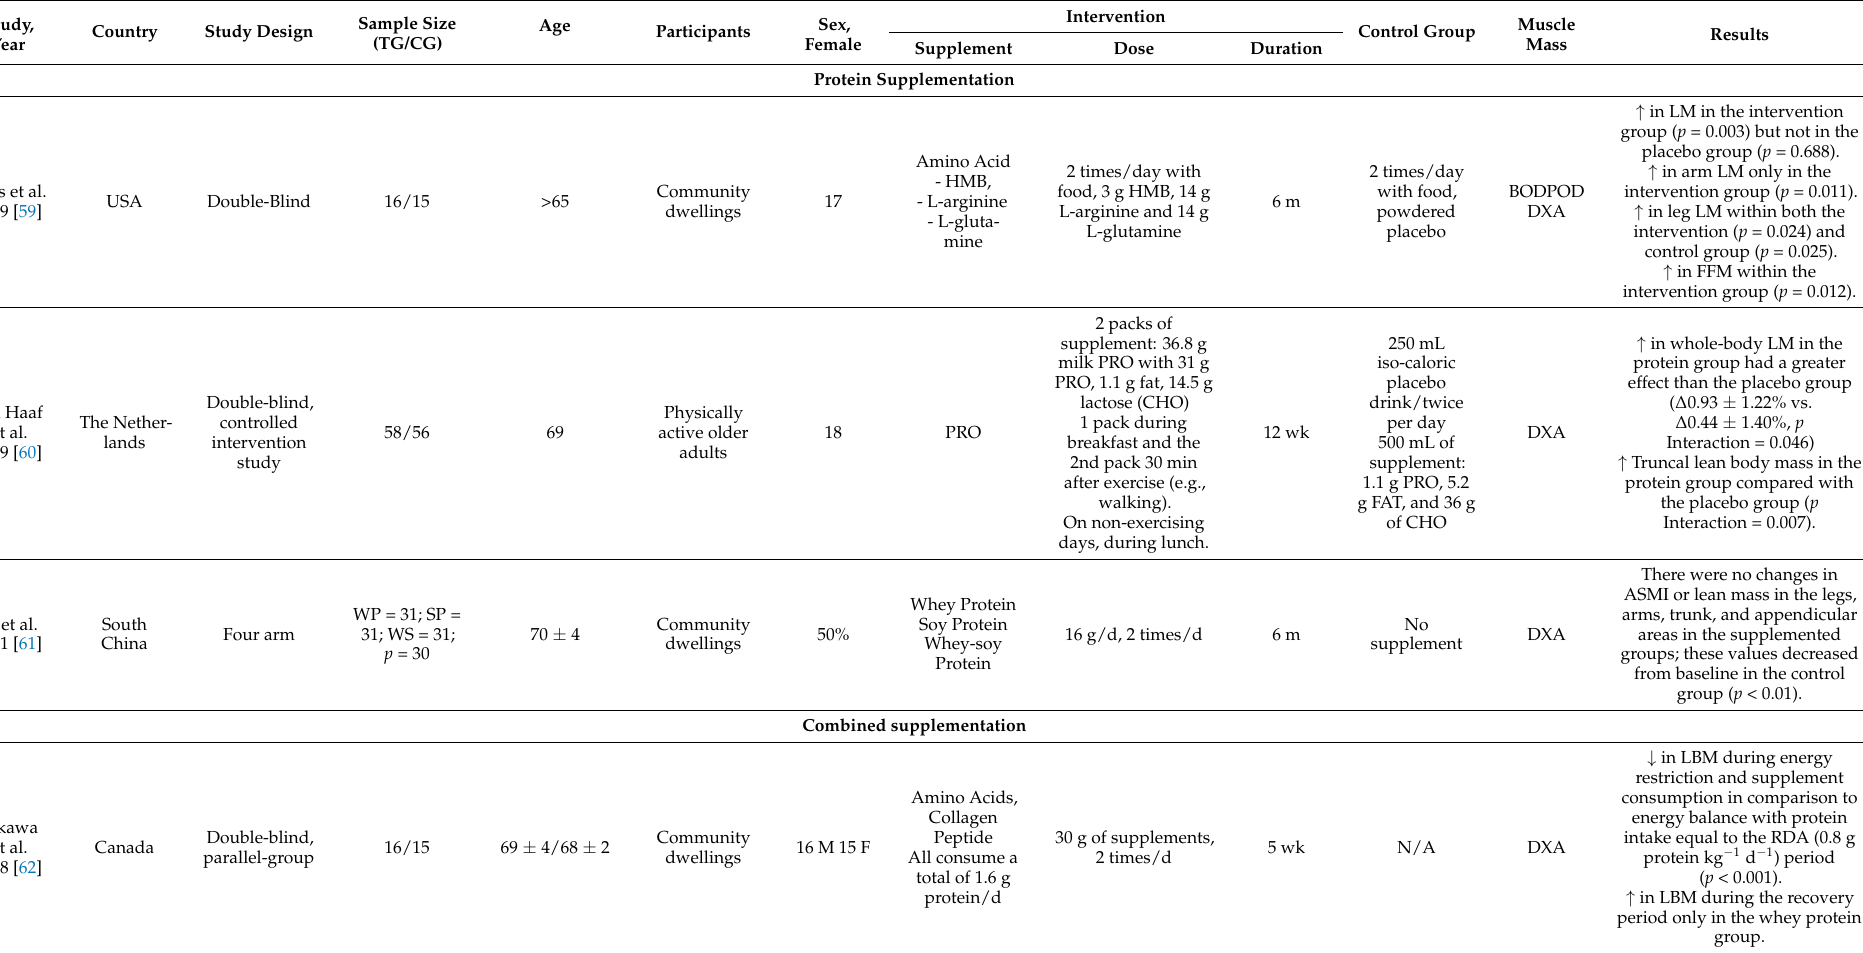
Table 2. Studies that examined the effect of diet on increasing muscle mass in the